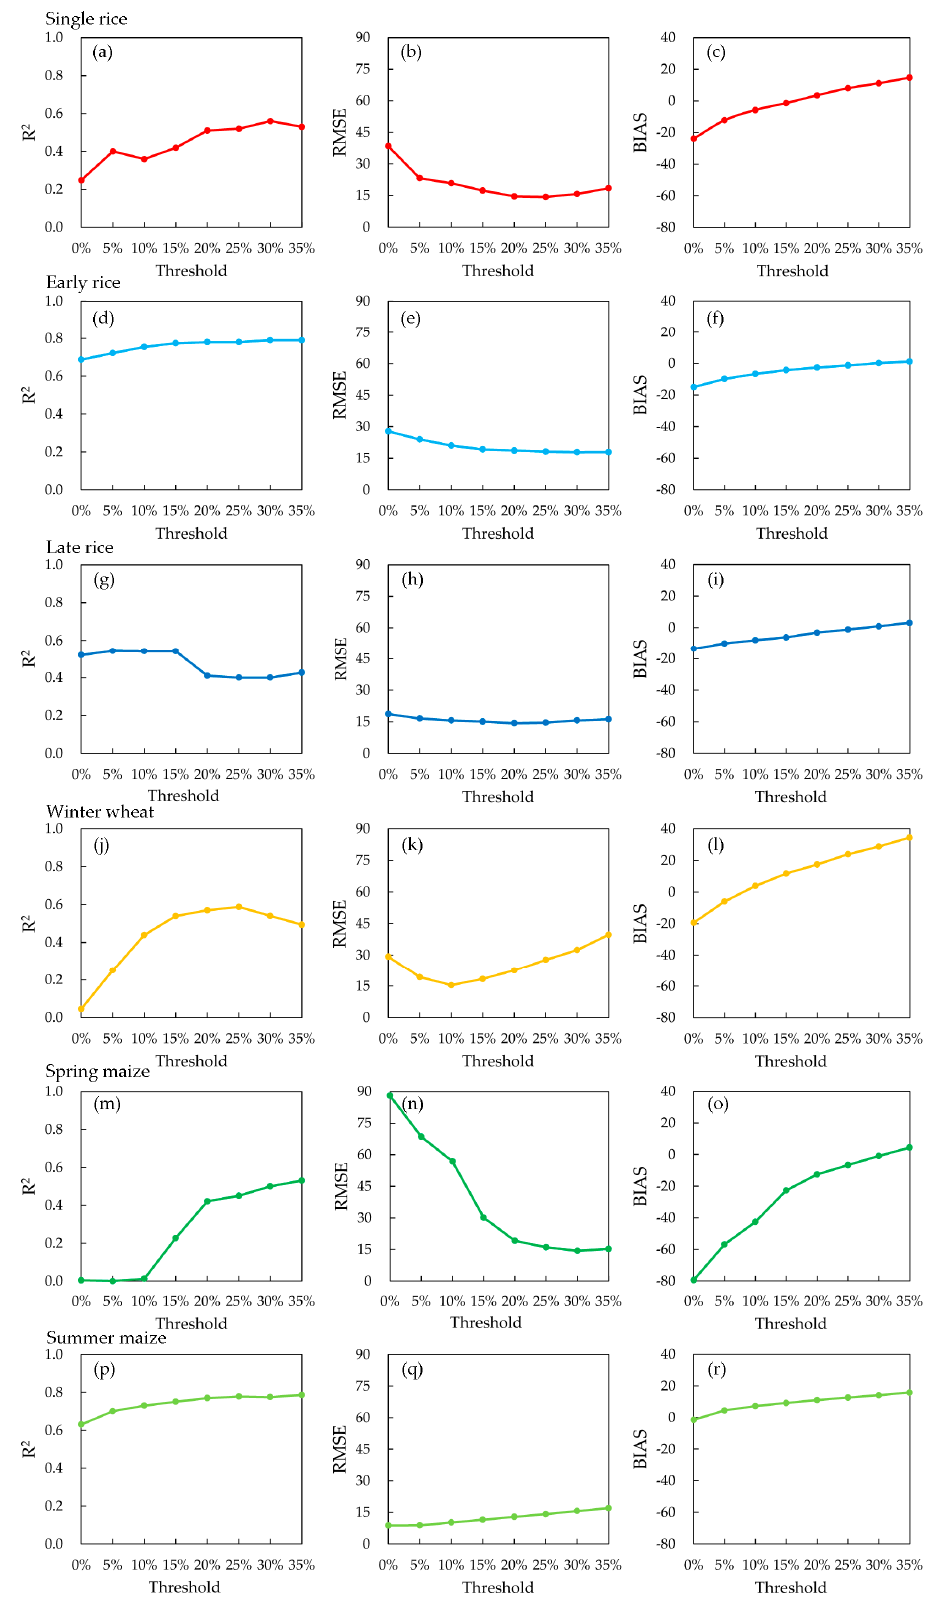
Figure 5. Crop-specific the start of the season (SOS) retrieval accuracies based on Normalized Difference Vegetation Index (NDVI) under different thresholds.